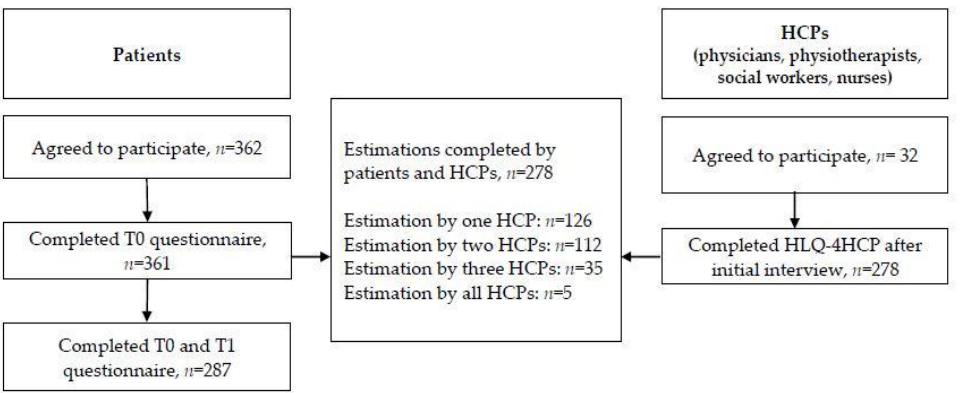
Figure 1. Estimations by patients and HCPs.